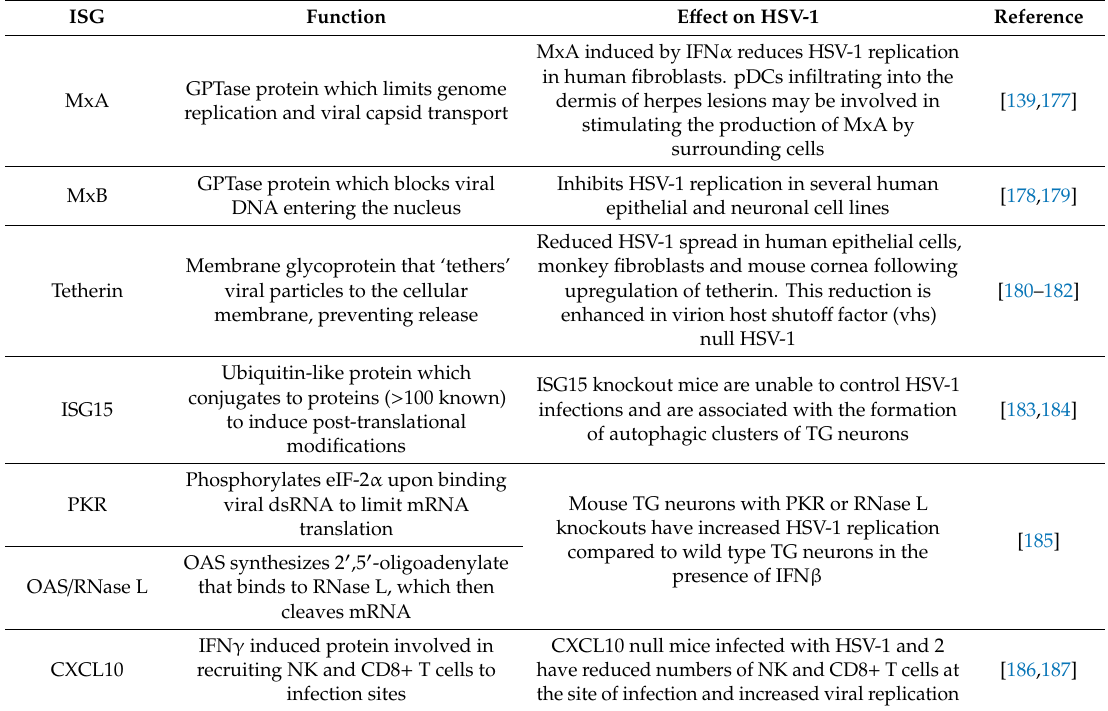
Table 1. ISGs known to limit HSV-1